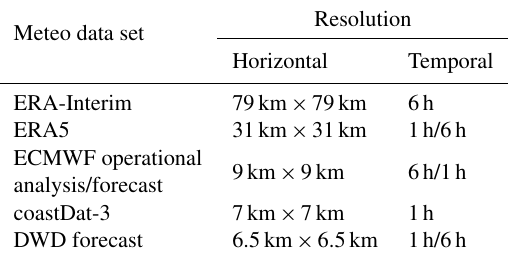
Table 2. Horizontal and temporal resolutions of the meteorological input